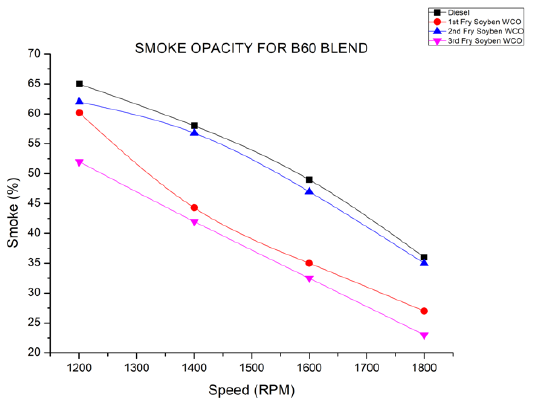
Figure 10. Smoke emission of different fry oils (B60 blend) at different rpm.